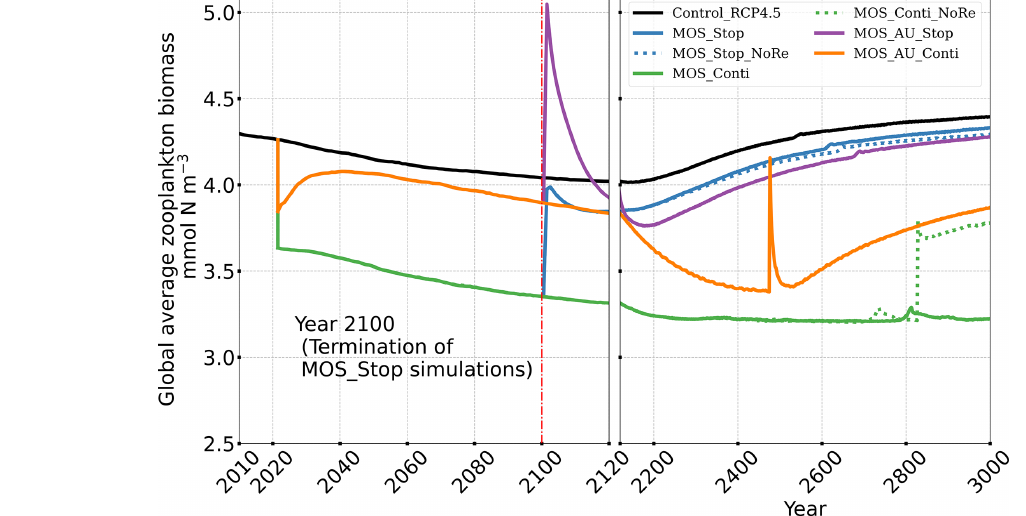
Figure B4. Plot of global averaged biomass of zooplankton.